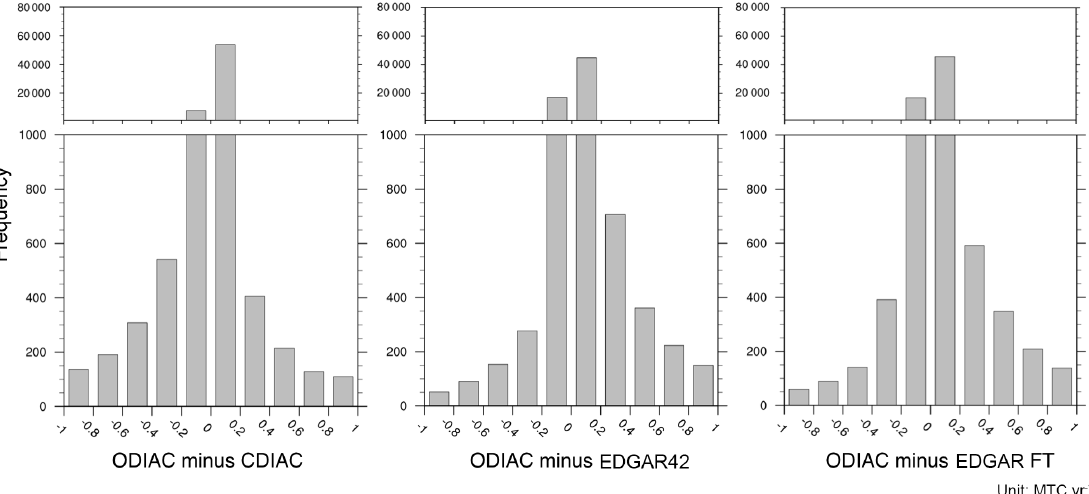
Figure A1. A histogram of the inter-emissions data differences from ODIAC. Values are given in the unit of million tons carbon per year (MTCyr − 1 ).